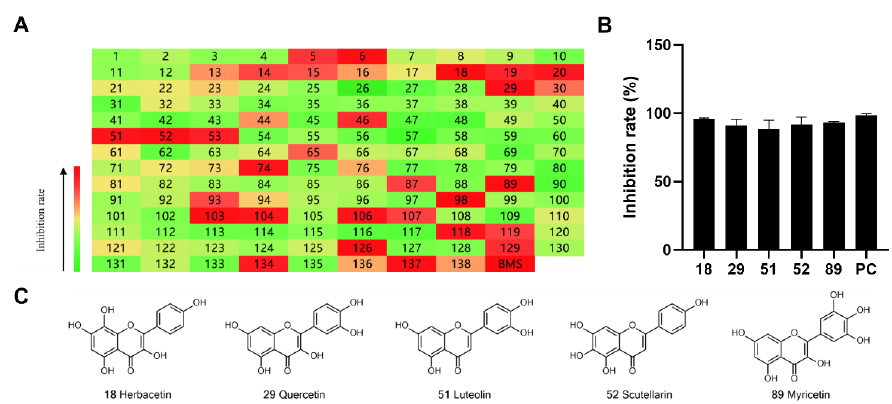
Figure 1. Preliminary screening of 138 natural flavonoids: ( A ) heatmap of the screen results, compounds ID: 1 – 138 ; colors from green to red indicate low to high inhibition rates; ( B ) inhibition rates of five ortho-dihydroxyphenyl flavonoids. BMS-303141, positive control (PC); and ( C ) structures of the five flavonoids.